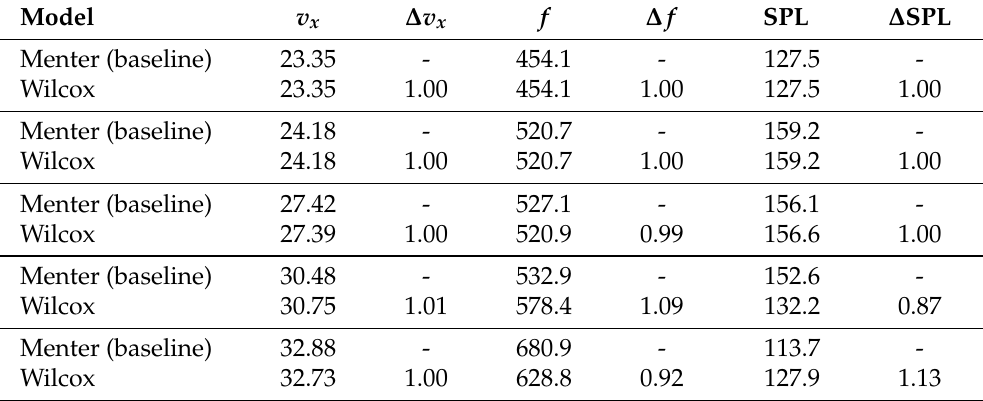
Table 7. Influence of the turbulence model on velocity, shedding frequency, and sound pressure